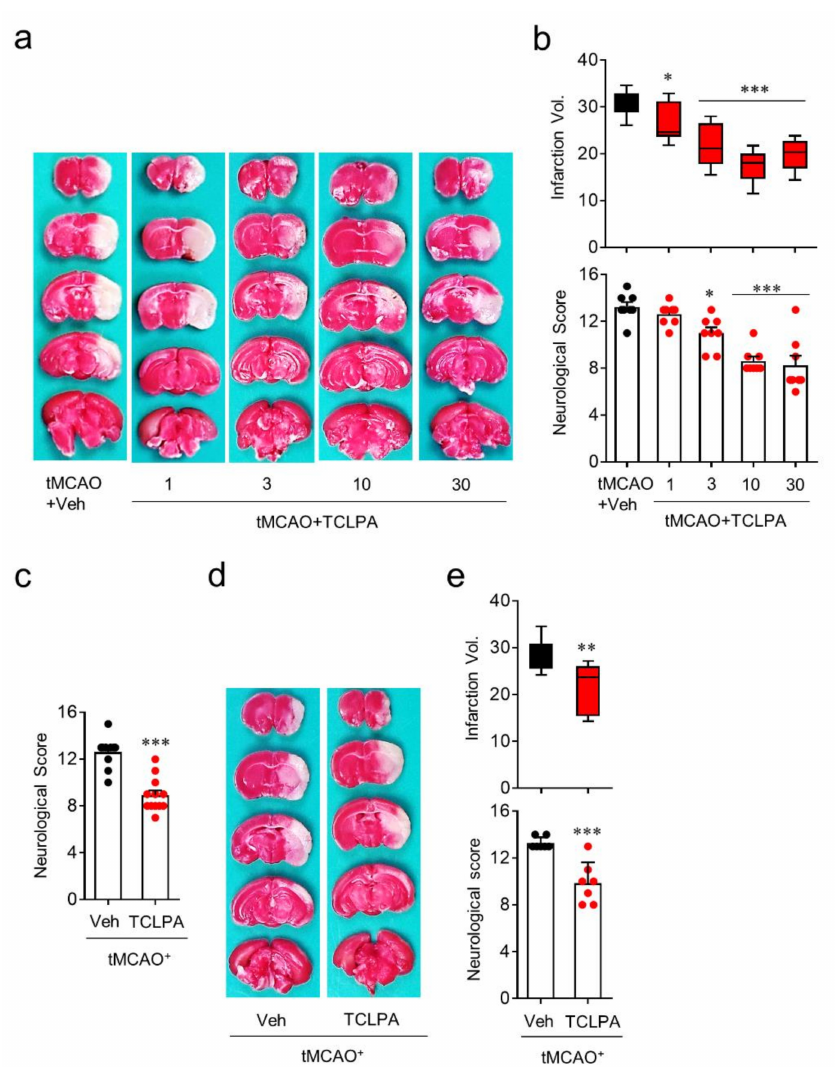
Figure 2. LPA 5 antagonism attenuates ischemic brain damage after tMCAO challenge. Mice were challenged with tMCAO. TCLPA5 (TCLPA: 1, 3, 10, and 30 mg / kg, i.p.) was administered to mice immediately after reperfusion. Alternatively, 10 mg / kg TCLPA5 was administered to mice at three hours after reperfusion. ( a , b ) E ff ects of TCLPA5 administration (1, 3, 10, and 30 mg / kg, i.p., administered immediately after reperfusion) on infarction volume ( a , b ) and neurological deficit score ( b ) were assessed at one day after tMCAO. Representative images for TTC-stained brain sections ( a ) and quantification of brain infarction volume or neurological score indicating neurological functions ( b ). n = 8 mice per group. ( c ) E ff ects of TCLPA5 administration (10 mg / kg, i.p., administered immediately after reperfusion) on the neurological deficit score were assessed three days after tMCAO. n = 10 (tMCAO + Veh) and 12 (tMCAO + TCLPA). ( d , e ) E ff ects of delayed TCLPA5 administration (10 mg / kg, i.p. , administration at three hours after reperfusion) on infarction volume ( d , e ) and neurological deficit score ( e ) were assessed at one day after tMCAO. Representative images for TTC-stained brain sections ( d ) and quantification of brain infarction volume or neurological score ( e ). n = 7 mice per group. * p < 0.05, ** p < 0.01, and *** p < 0.001 versus vehicle-administered tMCAO